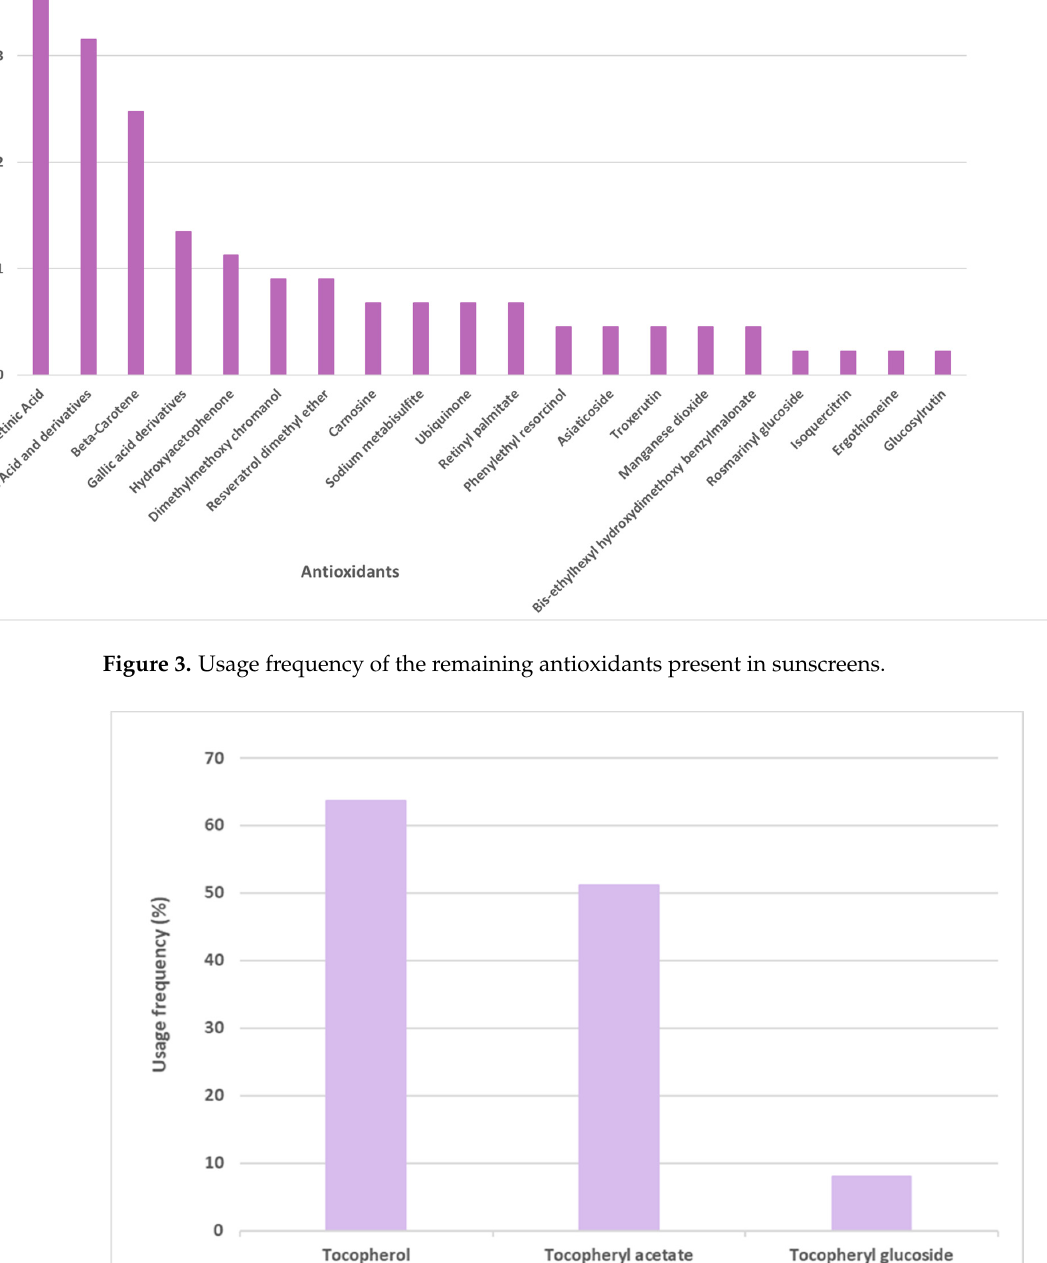
derivatives is five times inferior to the previous one. This could be explained by the fact that, in contrast to vitamin E, a fat-soluble molecule, vitamin C is a hydrophilic compound, and is thus challenging to introduce into cosmetic formulations.